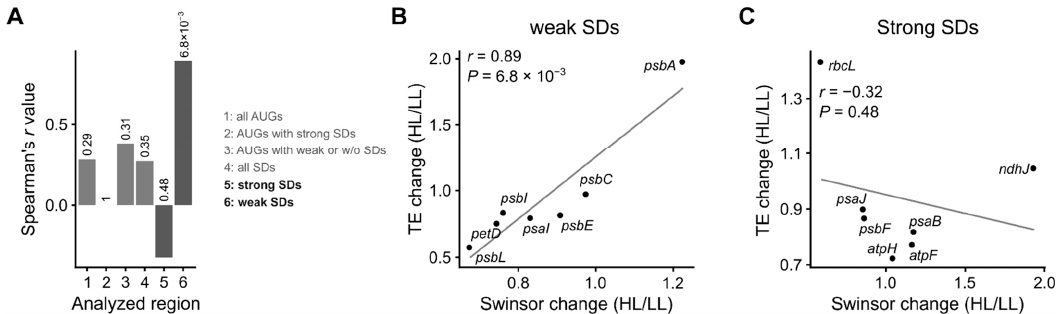
Figure 5. Correlations between changes in mRNA secondary structure and translation efficiency: The changes in mRNA secondary structure are calculated from the swinsor-normalized termination count values derived from NAI-N 3 probing by dividing the values from the high light exposed plants by those from the low light control plants (young leaves of seven-week-old plants). An increase of the swinsor value indicates a decrease in base pairing, i.e., less RNA secondary structure. Average changes for the indicated segments of each gene are given. The change in translation efficiency is calculated by dividing the normalized read counts for the ribosomal footprints by those for the transcripts of each coding region, and then dividing the resulting values from the high light treatment by those from the low light control. Only genes with sufficient coverage of the mRNA secondary structure (on average at least 10 reverse transcription stops per nucleotide) are included. Spearman’s r and p values are given. ( A ) Overview including all analyzed correlations. Columns 1–6 show Spearman’s r for the correlation between the change in translation efficiency and the change in SHAPE reactivities for different gene regions. The corresponding p values are given above the respective column. (1) start codons (AUG); (2) start codons of genes with strong Shine-Dalgarno sequences (SDs) (hybridization to the anti-SD of the 16S rRNA < − 9 kcal mol − 1 ); (3) start codons of genes with weak or no SD (> − 6 kcal mol − 1 ); (4) SDs; (5) SDs of genes with strong SD (< − 9 kcal mol − 1 ); and (6) SDs of genes with weak SD (> − 6 kcal mol − 1 ). The plots for all these analyses can be found in Supplemental Figure S15, where also an analysis of additional regions is included (see also Supplemental Figure S16). The plots for the highlighted correlations (5) and (6) are shown in ( B ) (change of structure at the SDs of genes with strong SD) and ( C ) (SDs of genes with weak SD).